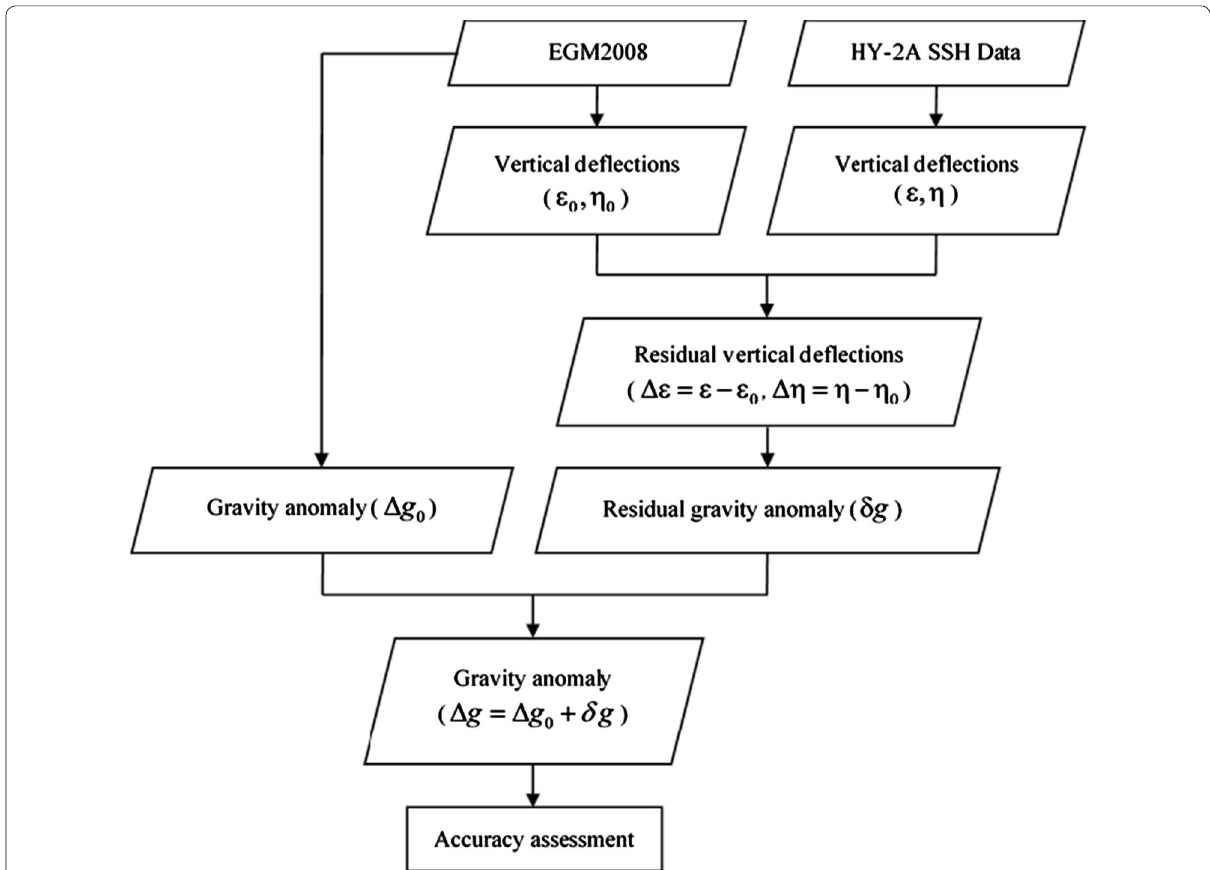
Fig. 2 Flowchart of the remove–restore